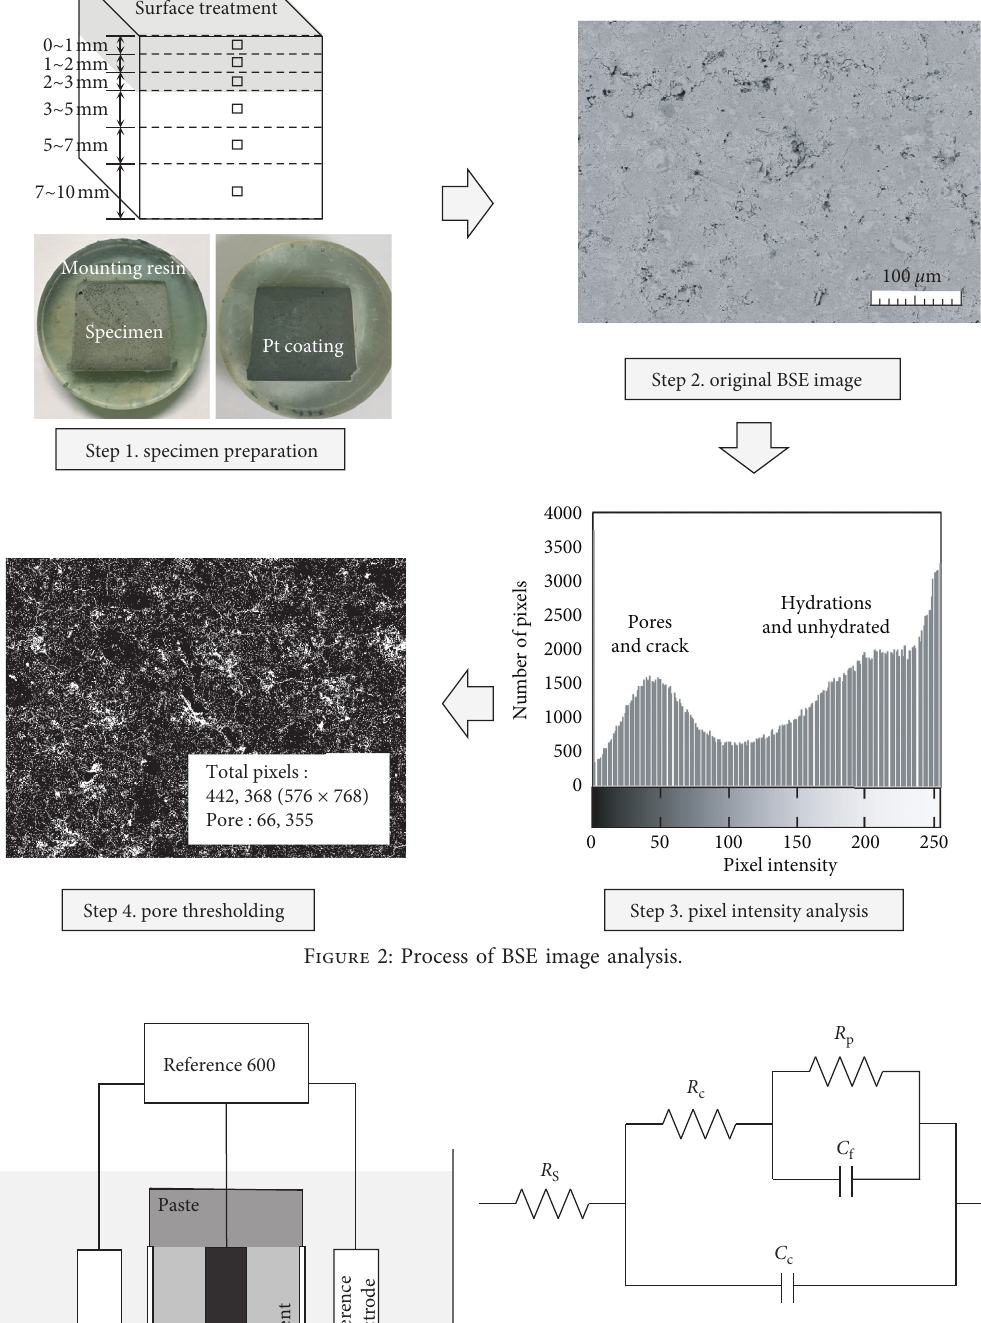
Figure 3: Set-up and equivalent electrical circuit for EIS